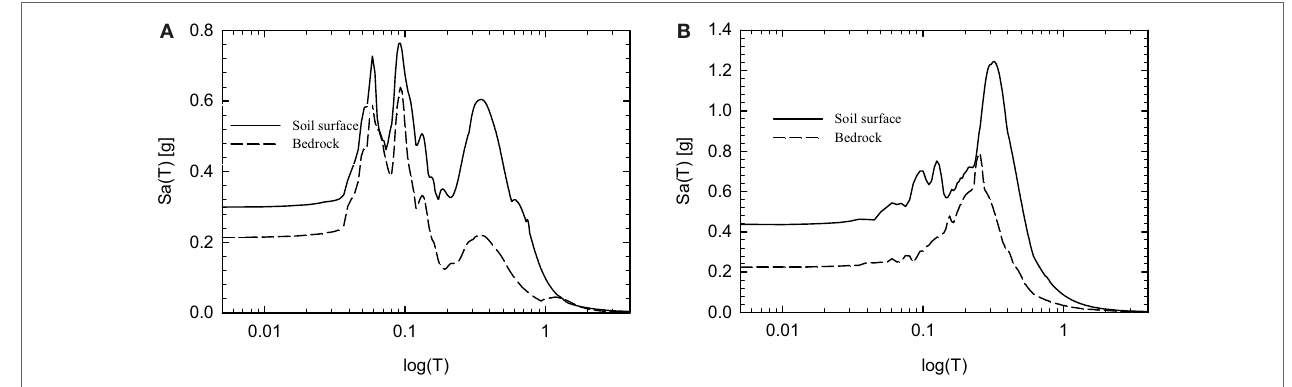
FigUre 13 | Val nerina earthquake (a) and Friuli earthquake (B) comparisons between bedrock and soil surface results